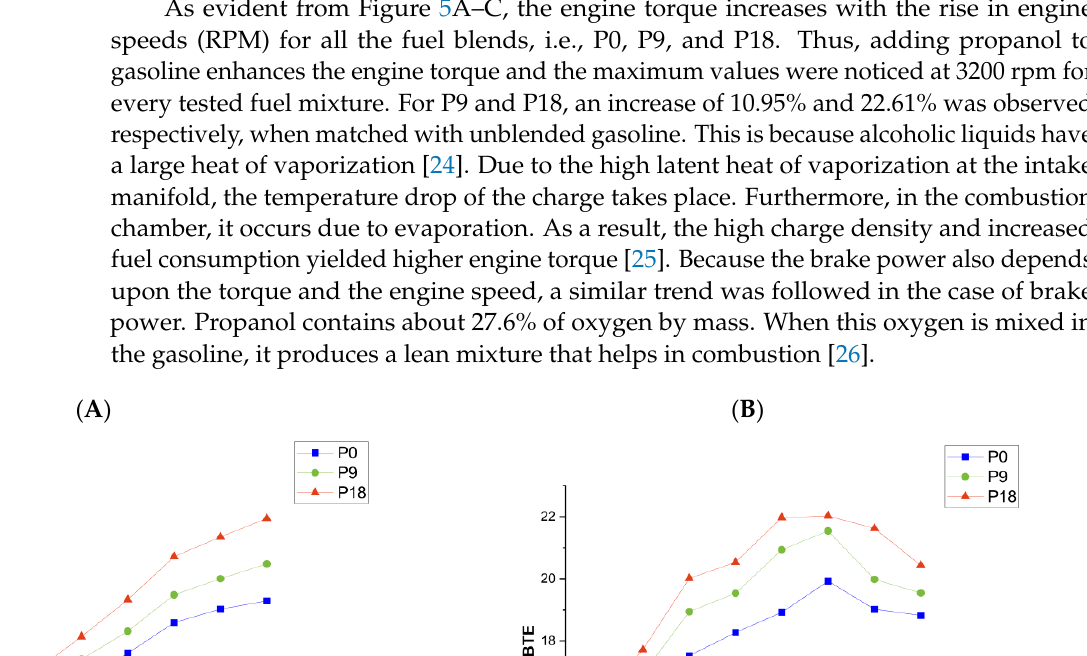
Figure 4. ( A , B ) Comparison of zinc and calcium for various lubricant oils.